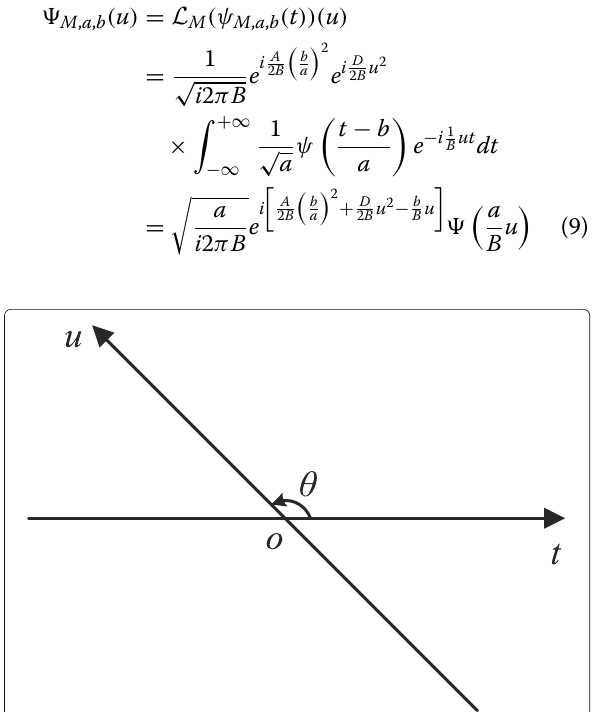
Fig. 2 The time-LCD-frequency